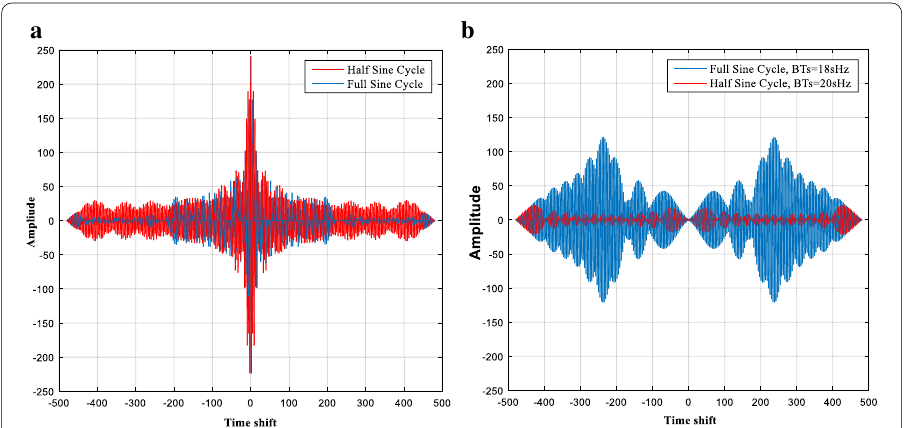
Fig. 3 Auto- and cross-correlation of a full cycle and half cycle sine chirp a auto-correlation of full sine and half sine cycle nonlinear chirp, b cross-correlation of full sine and half sine cycle nonlinear chirp